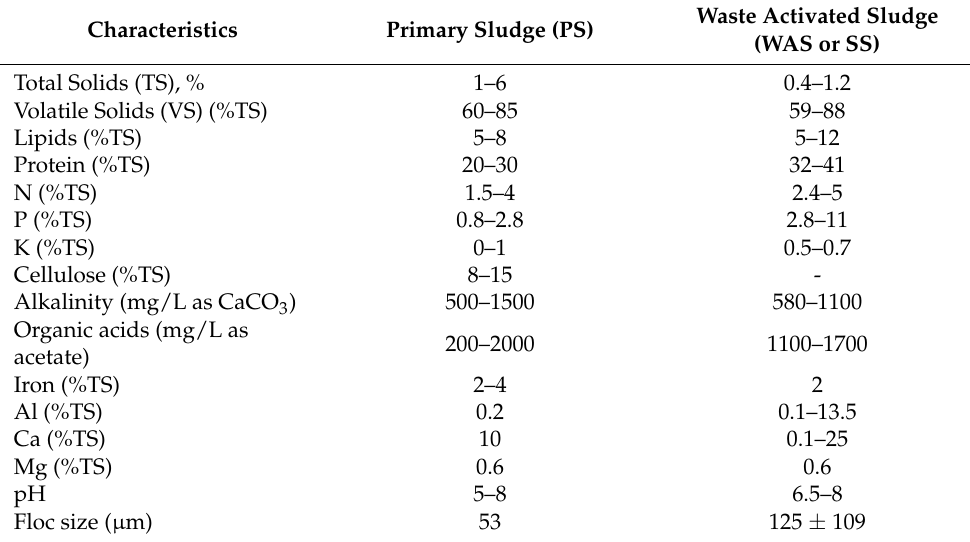
Figure 2. Sewage sludge (bio)floc structure. Table 1. Typical characteristics of primary and waste activated sludge (WAS), as adapted from literature